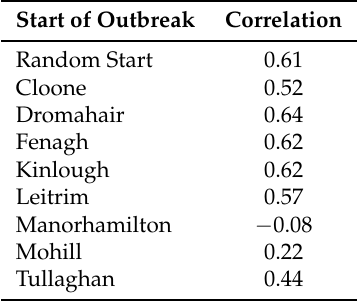
Table 11. Correlations between the percent of runs that lead to an outbreak in a town and the in-degree centrality of the town by starting location of the outbreak.